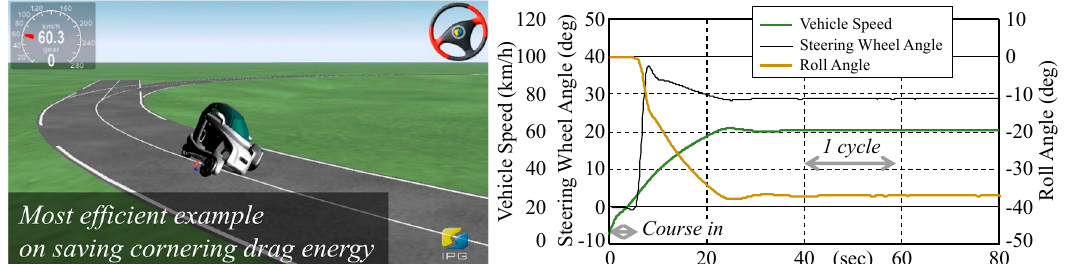
Figure 30. Driving on steady circle.